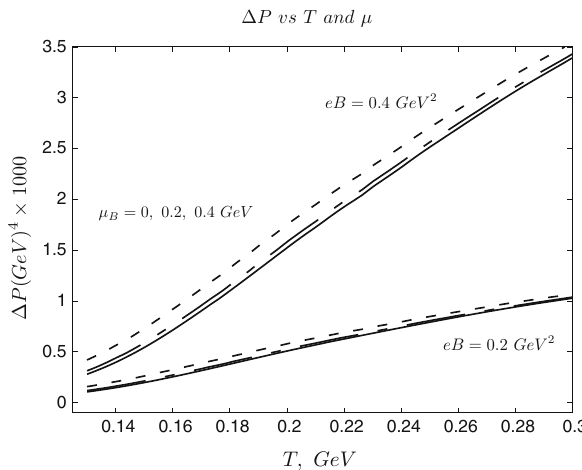
= 0 . 2 GeV, and the dashed – for B